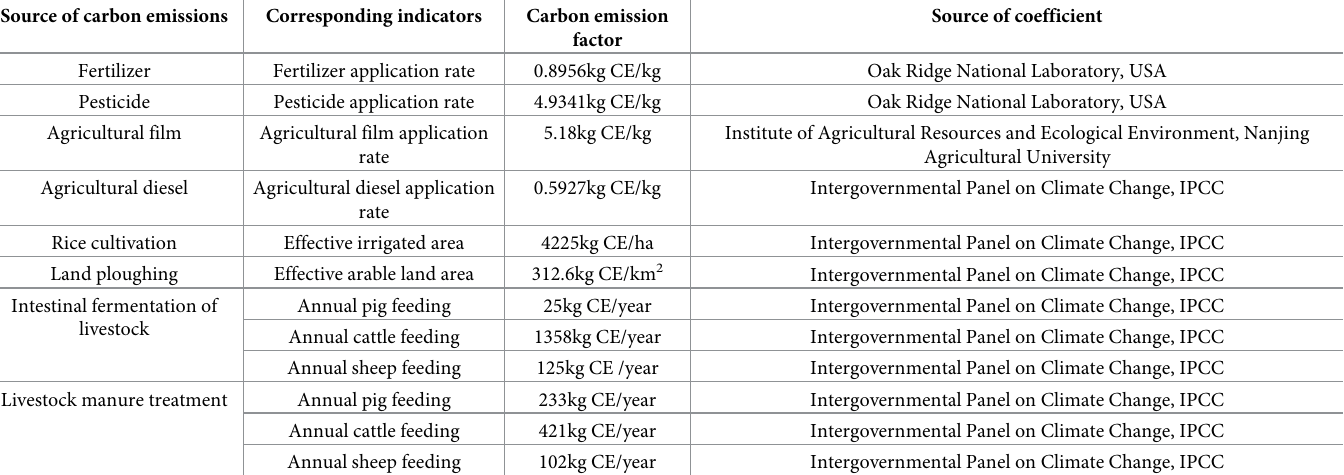
Table 1. Agricultural carbon emission source coefficient and corresponding index